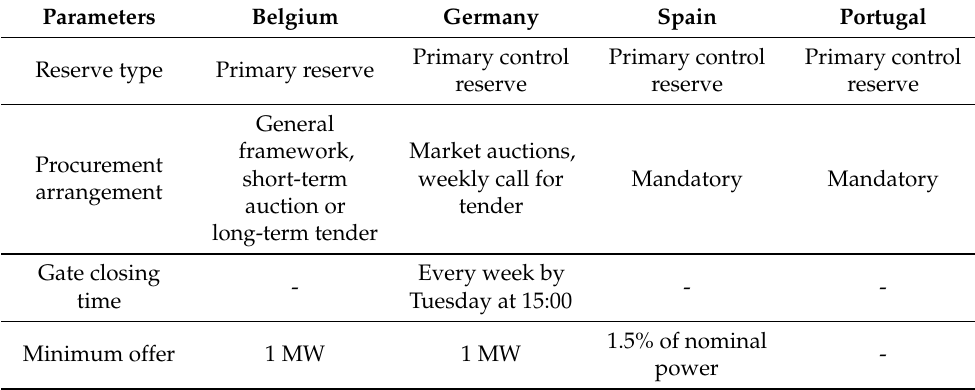
Table 2. Summary of FCR services unified under ENTSO-E classification, including Belgium, Ger- many, Spain and